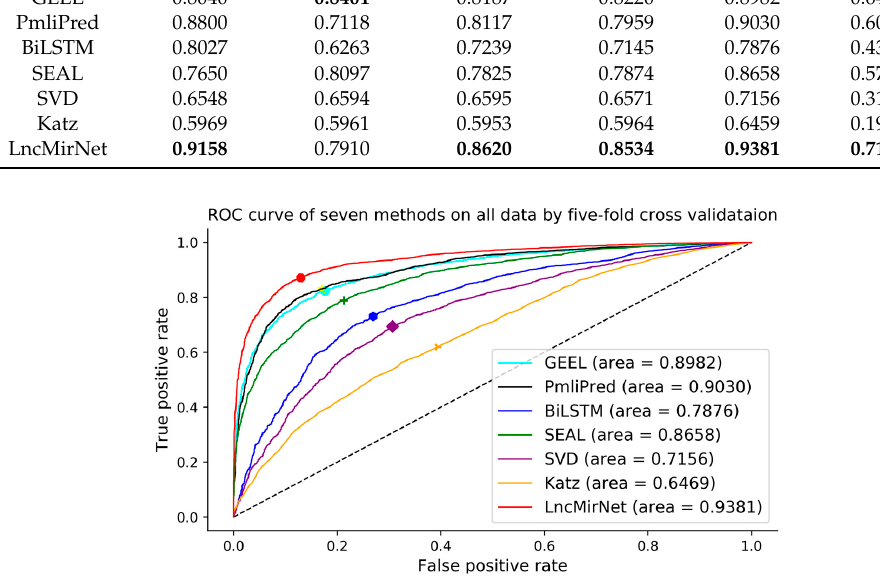
Figure 3. Receiver operating characteristic curves of seven methods on all data by five-fold cross validation.